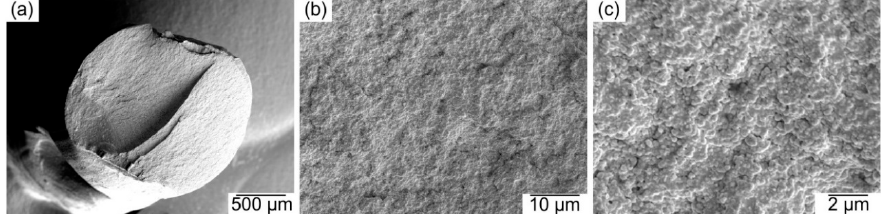
Figure3. Morphologyofthecryofracturedfeedstockfilamentat: ( a )100timesmagnification;( b )5000times magnification and ( c ) 20,000 times magnification. Figure 3. Morphology of the cryofractured feedstock filament at: ( a ) 100 times magnification; ( b ) 5000 times magnification and ( c ) 20,000 times magnification. Figure 3. Morphology of the cryofractured feedstock filament at: ( a ) 100 times magnification; ( b ) 5000 times Figure 3. Morphology of the cryofractured feedstock filament at: ( a ) 100 times magnification; ( b ) Figure 3. Morphologyofthecryofracturedfeedstockfilamentat: ( a )100timesmagnification; ( b )5000times 5000 times magnification and ( c ) 20,000 times magnification. magnification and ( c ) 20,000 times magnification and ( c ) 20,000 times magnification.